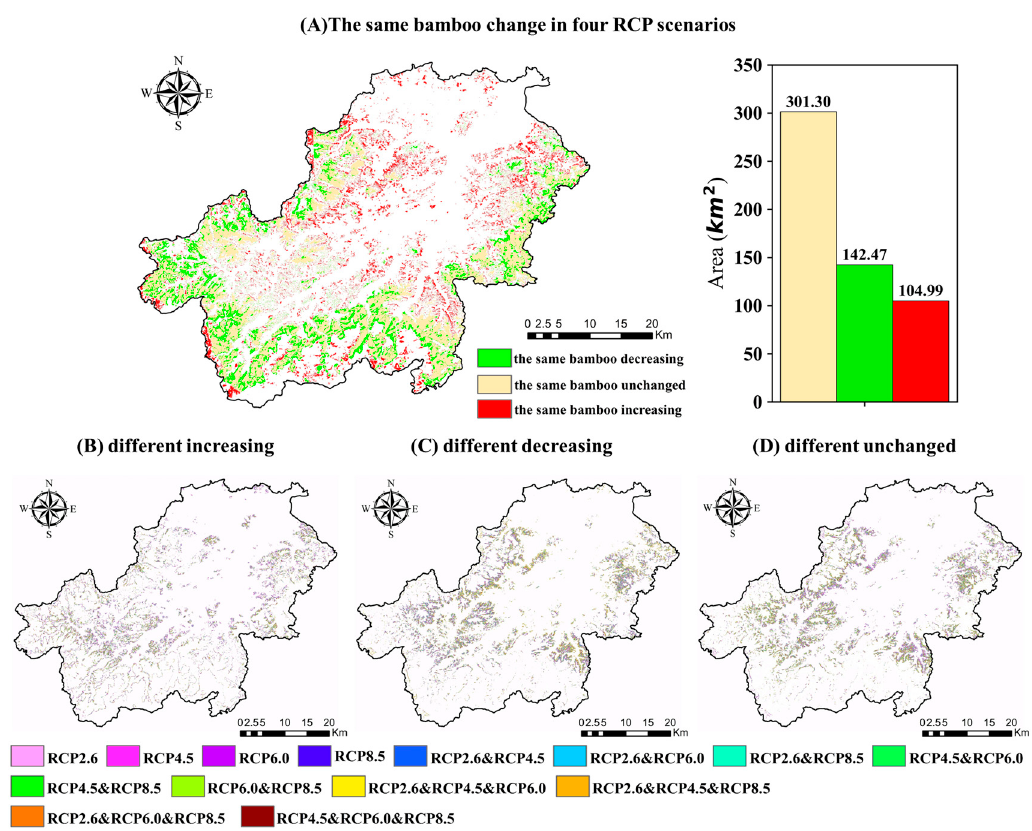
Figure 14. ( A ) the same regions where bamboo forests will change under the four RCP scenarios from 2014 to 2049. ( B ) the different regions where bamboo forests will increase under the four RCP scenarios from 2014 to 2049. ( C ) the different regions where bamboo forests will decrease under the four RCP scenarios from 2014 to 2049. ( D ) the different regions where bamboo forests will be unchanged under the four RCP scenarios from 2014 to 2049.